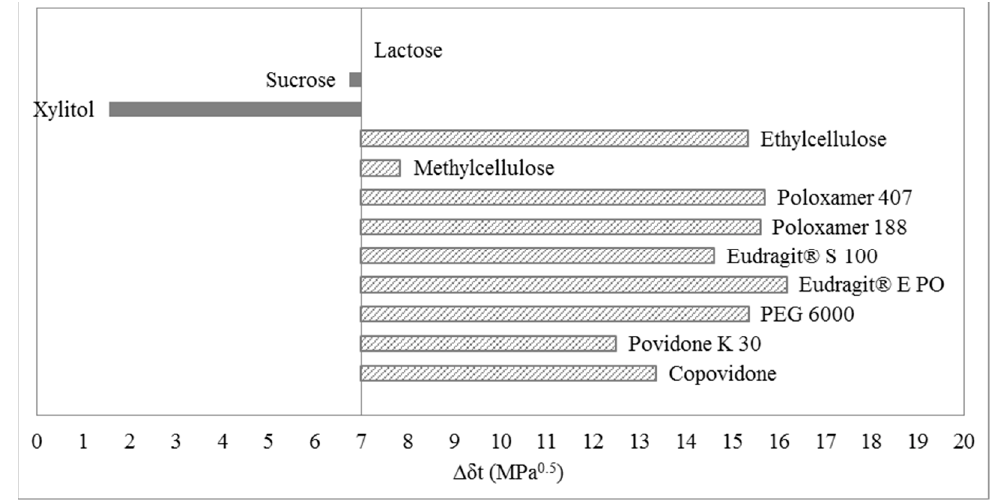
Figure 8. Bar graph according to Greenhalgh for ibuprofen lysinate; solubility parameters of ibuprofen lysinate were obtained using IGC.